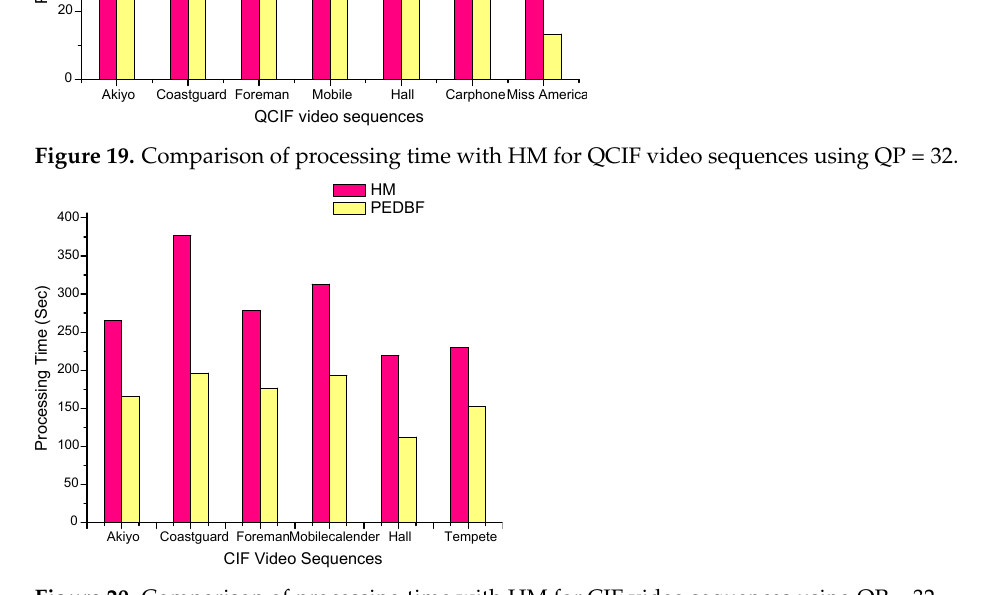
Figure 20. Comparison of processing time with HM for CIF video sequences using QP =